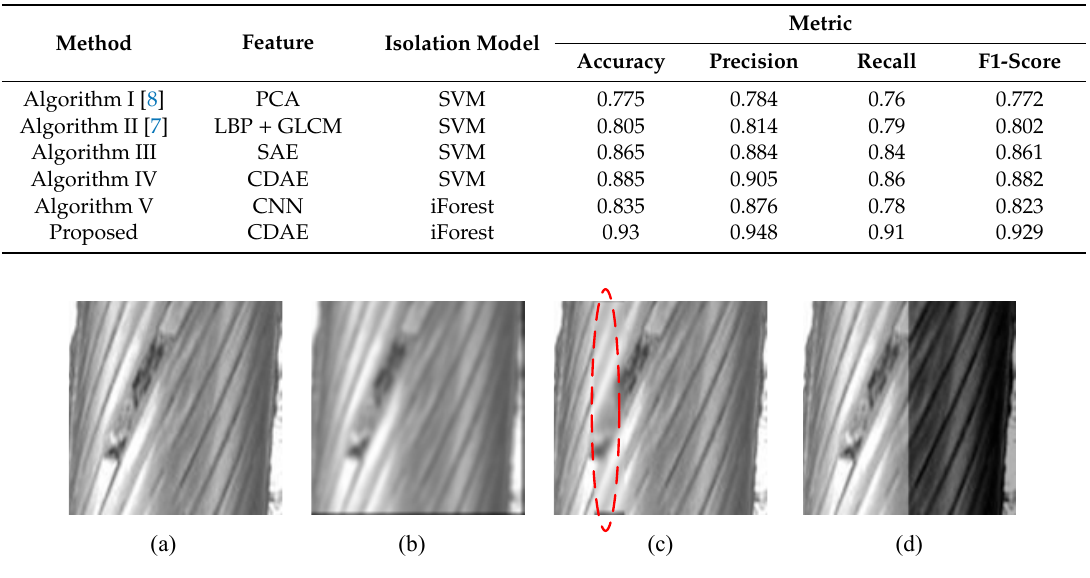
Table 2. Temperature and wildlife count in the three areas covered by the study. LBP: local binary patterns; GLCM: gray-level co-occurrence matrix; CDAE: convolutional denoising autoencoder; CNN: convolutional neural network.